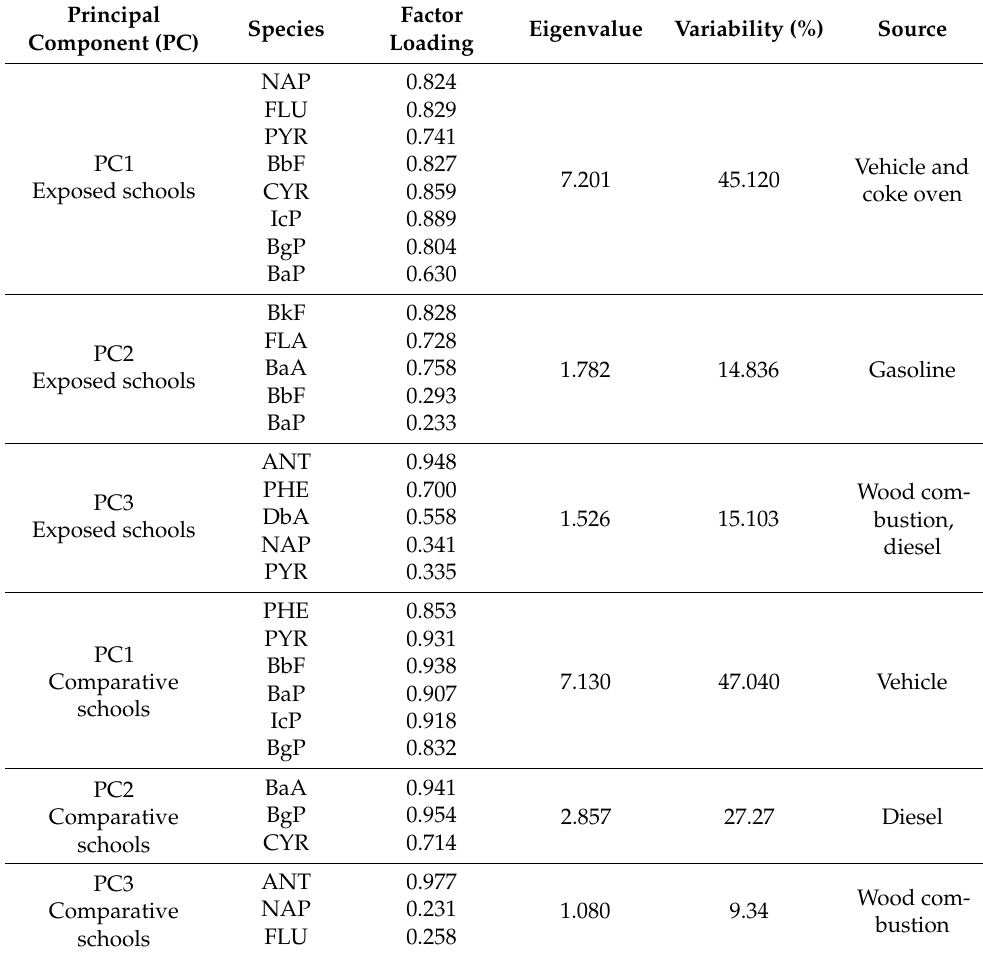
Table 2. Principal components analysis with varimax